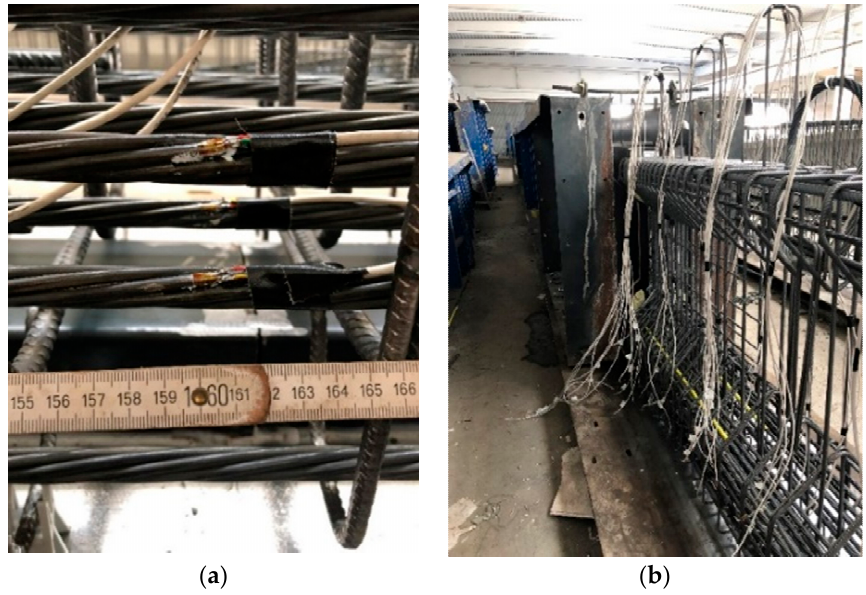
Figure 7. ( a ) Strain gauges attached on the strands; ( b ) Full view of the instrumented end zone.